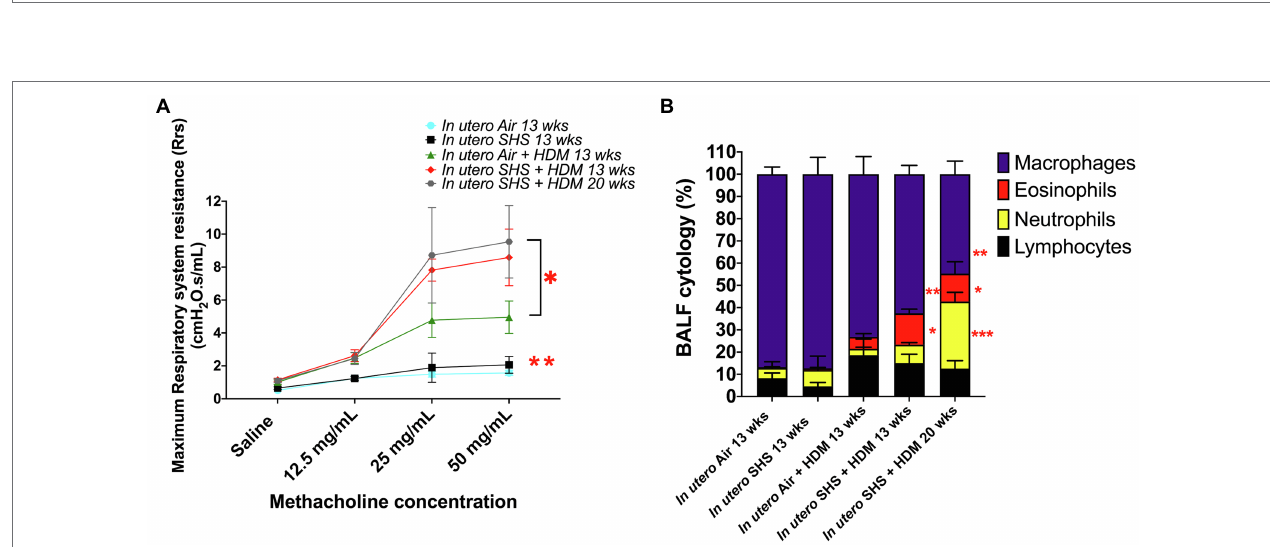
FIGURE 5 | 3 mg/m 3 of in utero SHS plus adult HDM increased lung resistance and altered BALF cytology. (A) Maximum respiratory system resistance (Rrs) measured using a FlexiVent system at 13 and 20 weeks of age in female mouse offspring. N = 6–10 per group; data are expressed as mean ± SEM. ANOVA followed by Tukey’s test for multiple comparisons, * p < 0.05: in utero SHS plus HDM group statistically different from in utero air plus HDM group, ** p < 0.05: in utero air or SHS plus HDM groups statistically different from in utero air or SHS plus saline groups. (B) Cytology analysis showing the percentage of leukocytes recovered from BALF of female mouse offspring at 13 and 20 weeks of age. N = 9–10 per group; data are expressed as mean ± SEM. ANOVA followed by the Tukey’s test for multiple comparisons, eosinophils: * p < 0.05: statistically different from in utero air or SHS plus saline and in utero air plus HDM groups; macrophages: ** p < 0.05: statistically different from in utero air or SHS plus saline groups; neutrophils: *** p < 0.05: statistically different from all other